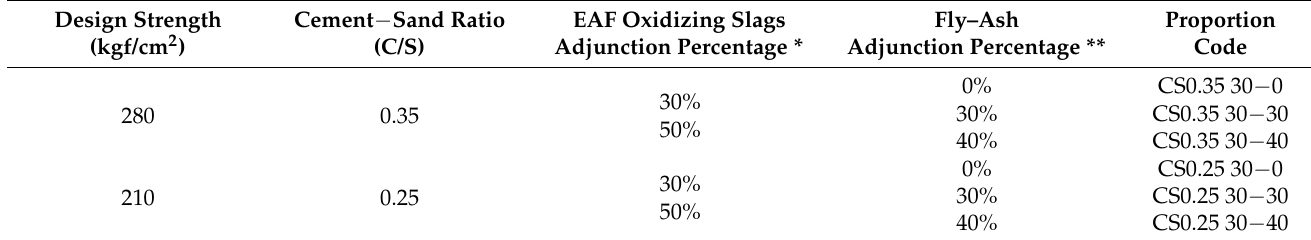
Table 2. EAF oxidizing slag decoration material combination.